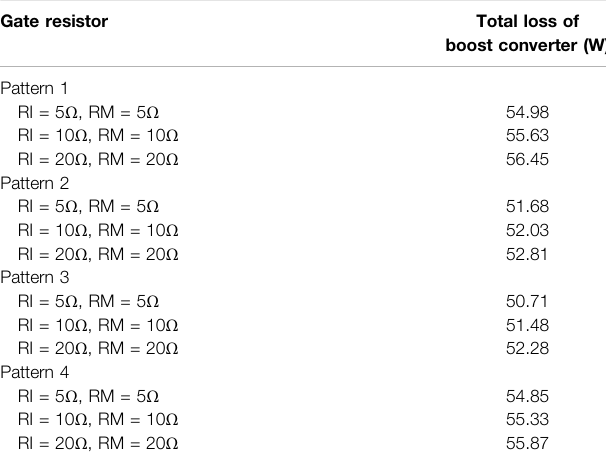
TABLE 2| Relationshipbetweengate resistorand total loss ofboost converter (all gate resistors are changed